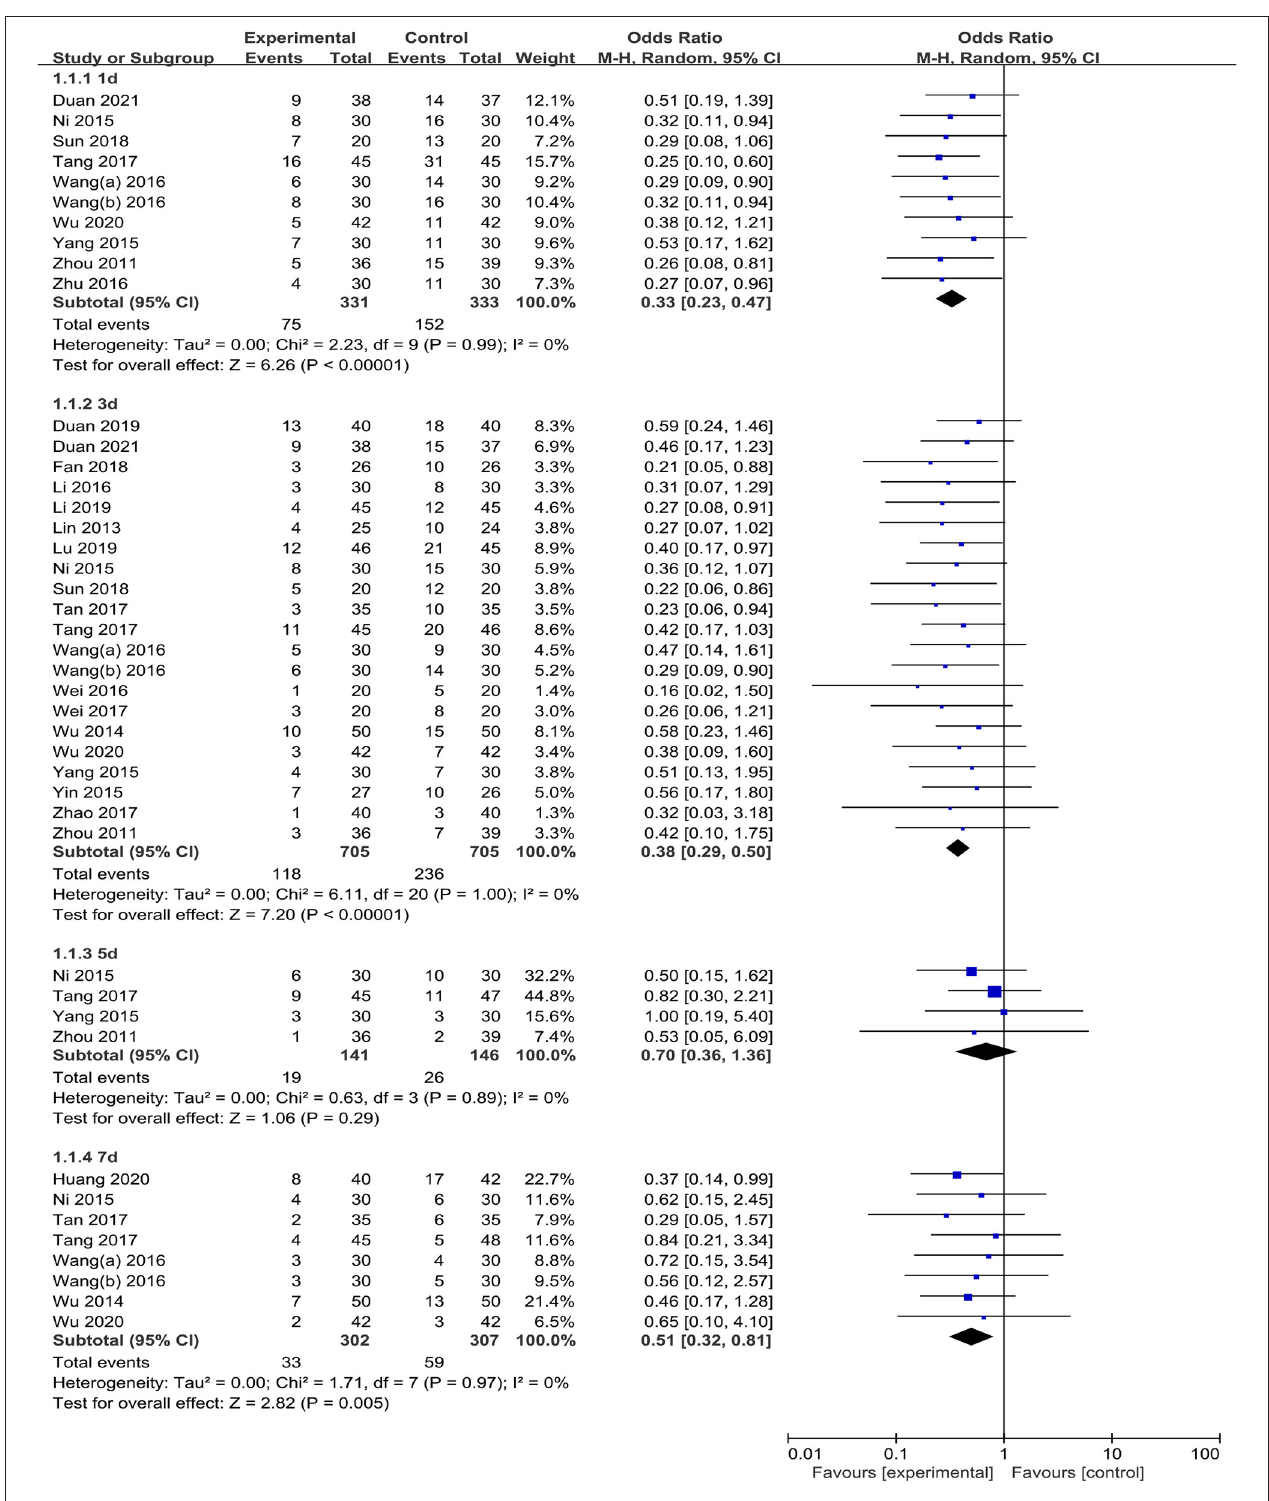
FIGURE 3 | Meta-analysis and forest plot for the incidence of POCD at different periods.